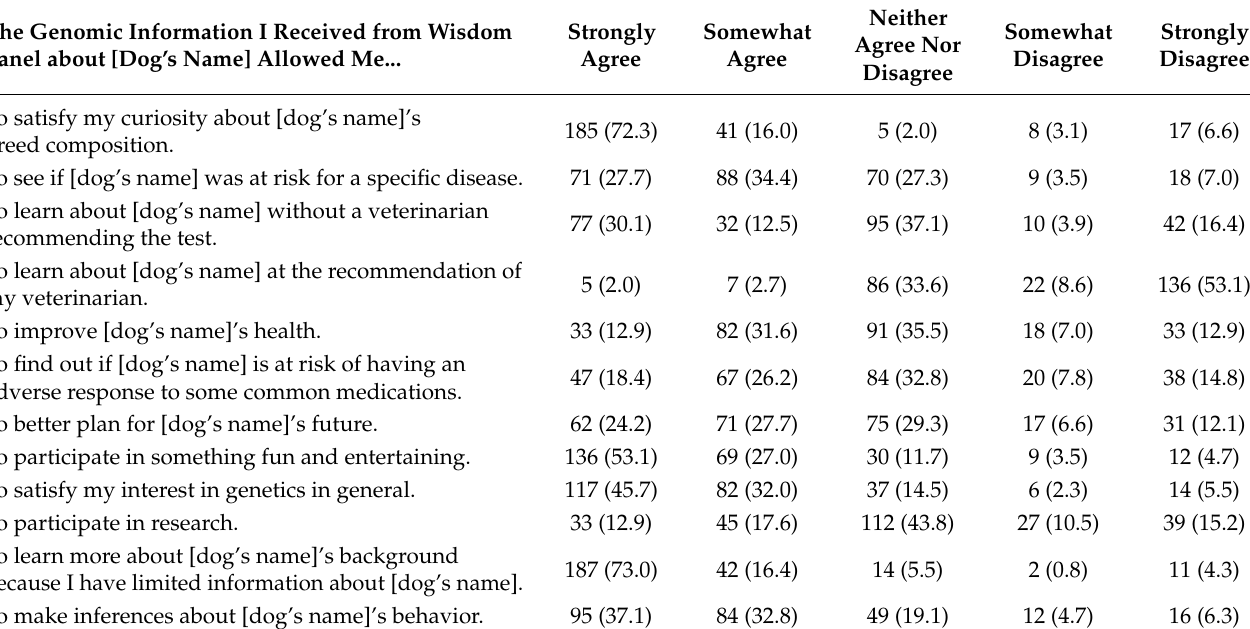
Table 4. Participant responses to Likert items about their motivations for having their dog genetically tested. Reported as N